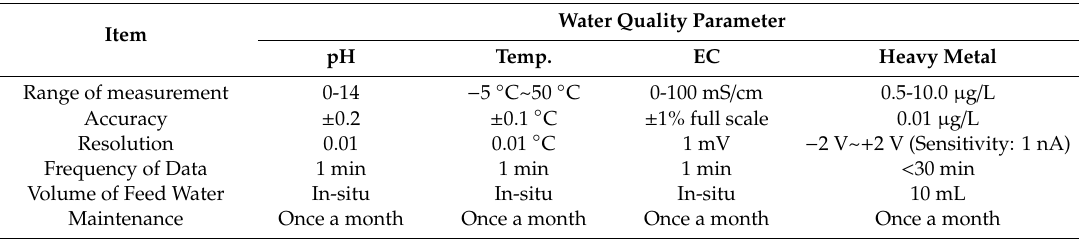
Table 1. Specification of commercial sensors used in automatic real-time monitoring system.